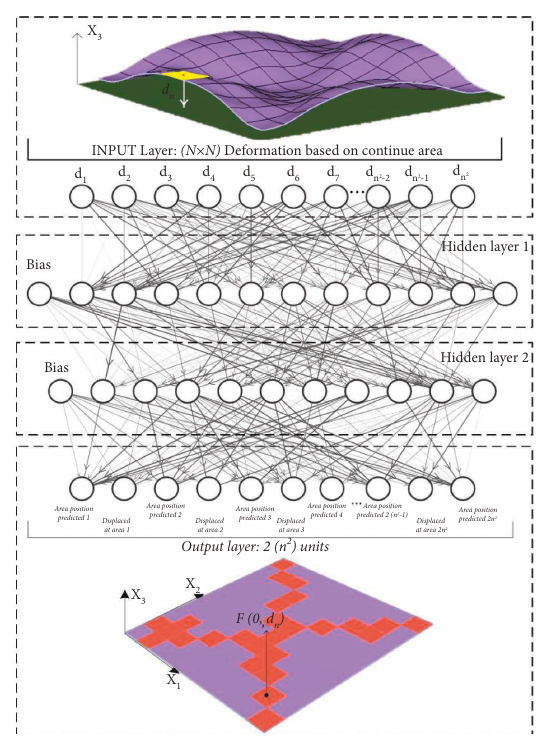
Figure 4: The concept of ANN for predicting areas heated with initial flat steel